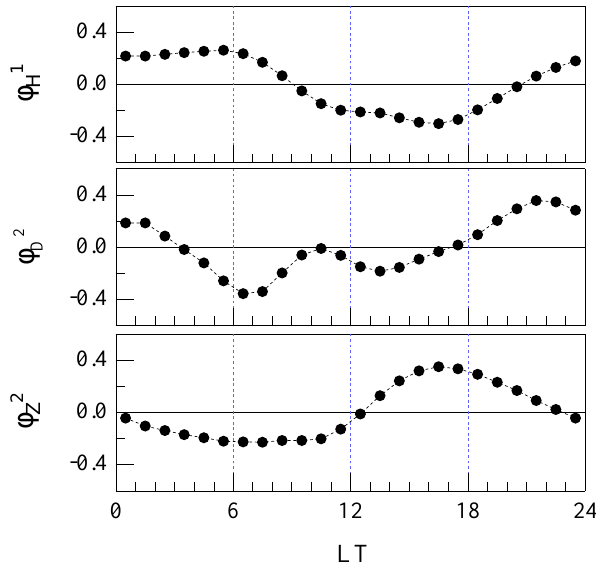
Fig. 6. The EOFs associated with the disturbance daily variations for H, D and Z magnetic field